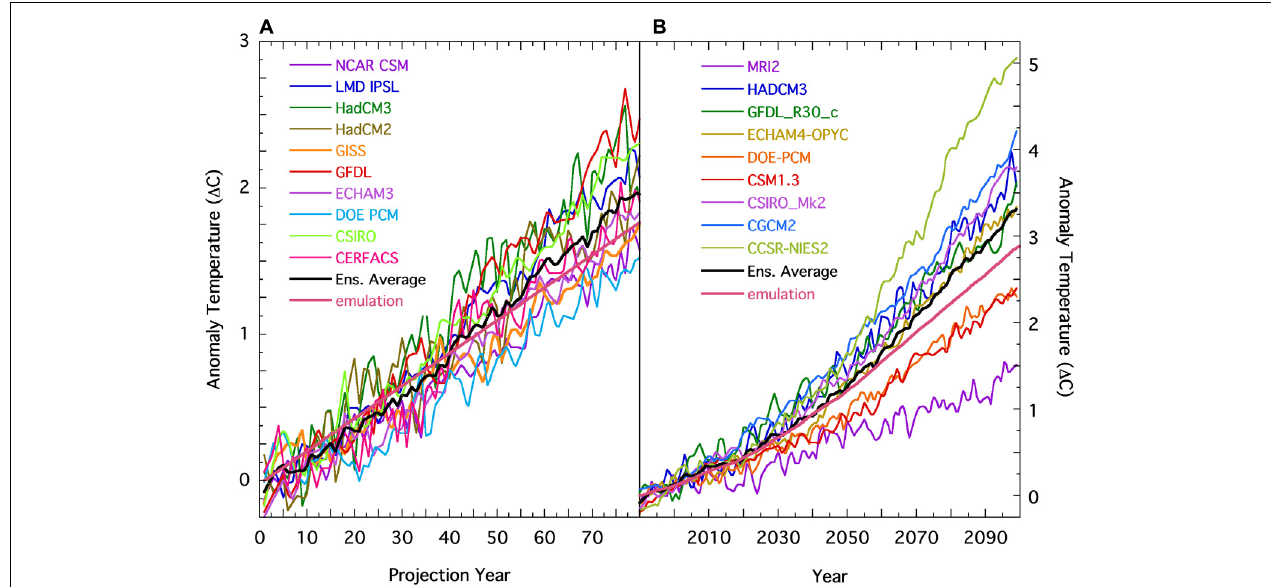
FIGURE 1 | (A) Climate model projections of future GASAT anomalies following a 1% annual growth in atmospheric [CO 2 ]; ( — ), the model ensemble average, and; ( — ), equation 1. Model realizations were obtained from Figure 27 in Covey et al. (2001) (see also Figure 3.10 in AchutaRao et al., 2004). (B) Lines as for part a, showing multiple GCM projections of the SRES A2 scenario from the IPCC. The individual model realizations were obtained from Figure 9.6 in the WG1 Report of the IPCC 3AR (IPCC, 2001). The forcings for the SRES A2 scenario used for the equation 1 emulation were obtained from Appendix II, Table II.3.11 in the WG1 Report (IPCC, 2001). The smooth emulation lines are in the midst of the projection